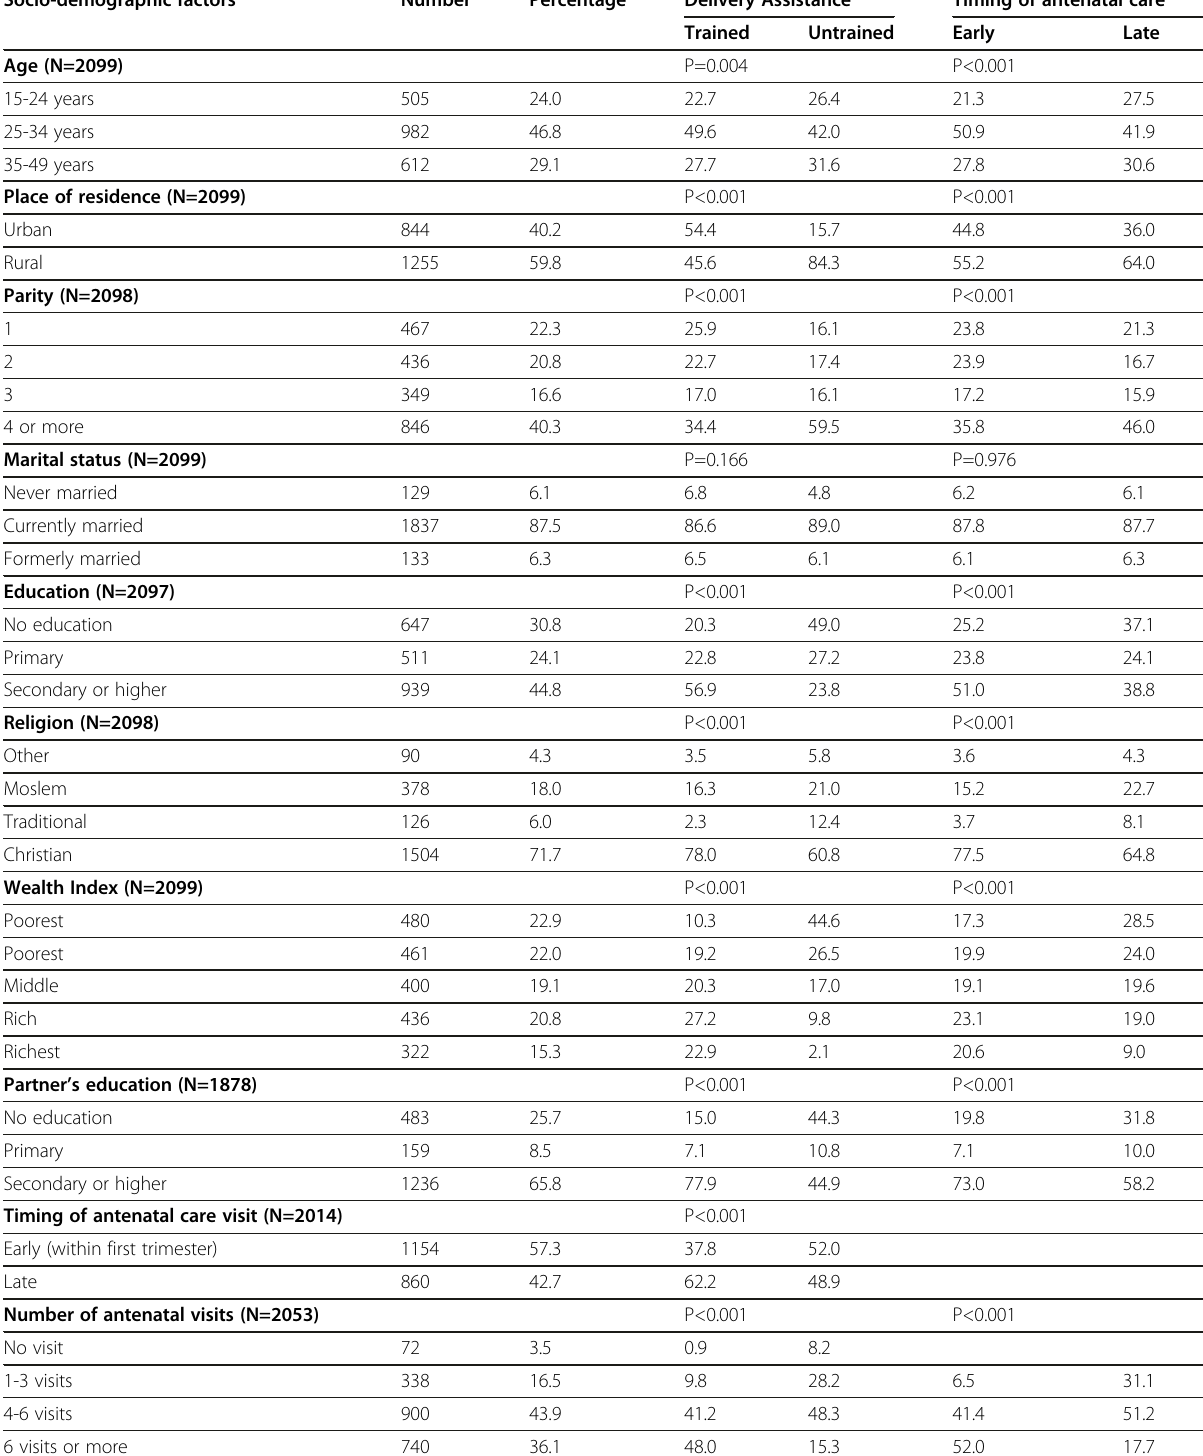
Table 1 Distribution of socio-demographic factors in relation to the timing of antenatal care visit and type of delivery assistance among Ghanaian